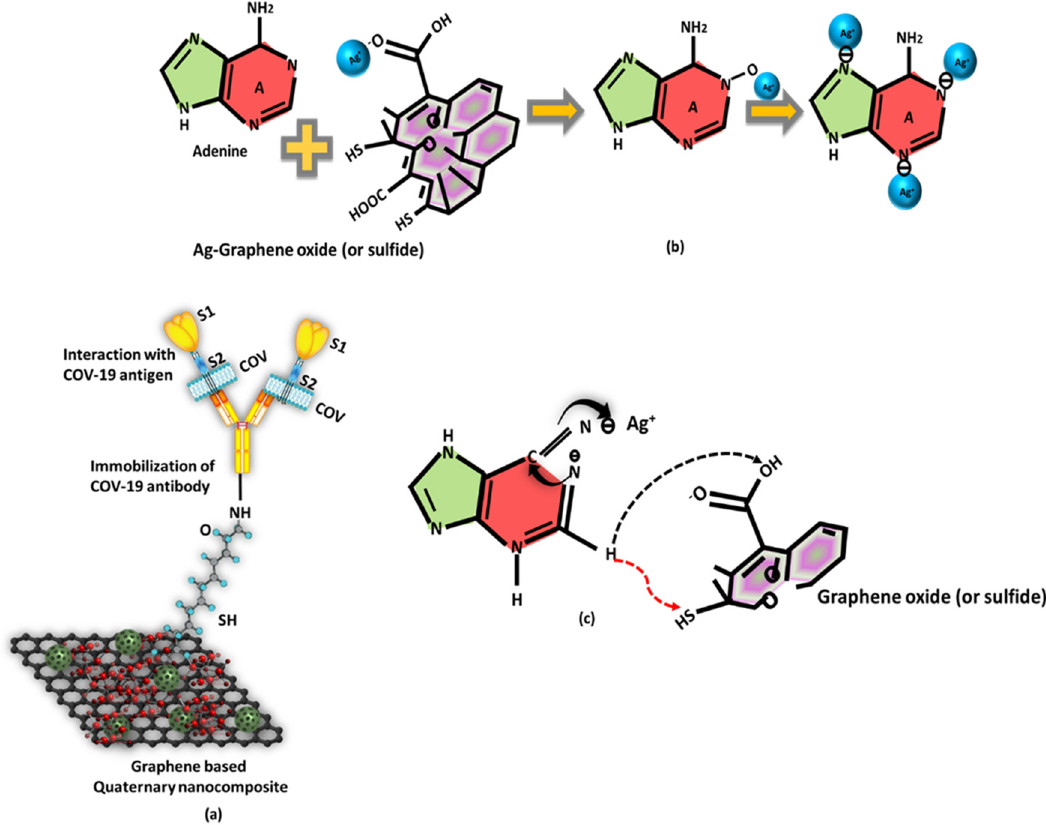
Figure 4: ( a ) Schematic presentation of the COVD - 19 viral antigen binding with graphene nanocomposite sensor with coordination with antibody, ( b ) proposed binding mechanism, and ( c ) adenine ring opening by silver nanoparticles on the graphene